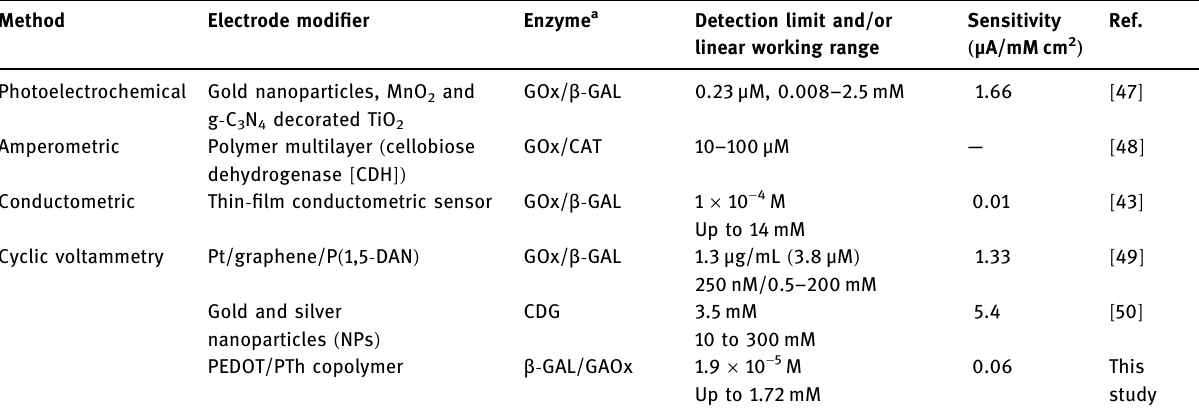
Table 1: Performance values of some lactose sensors